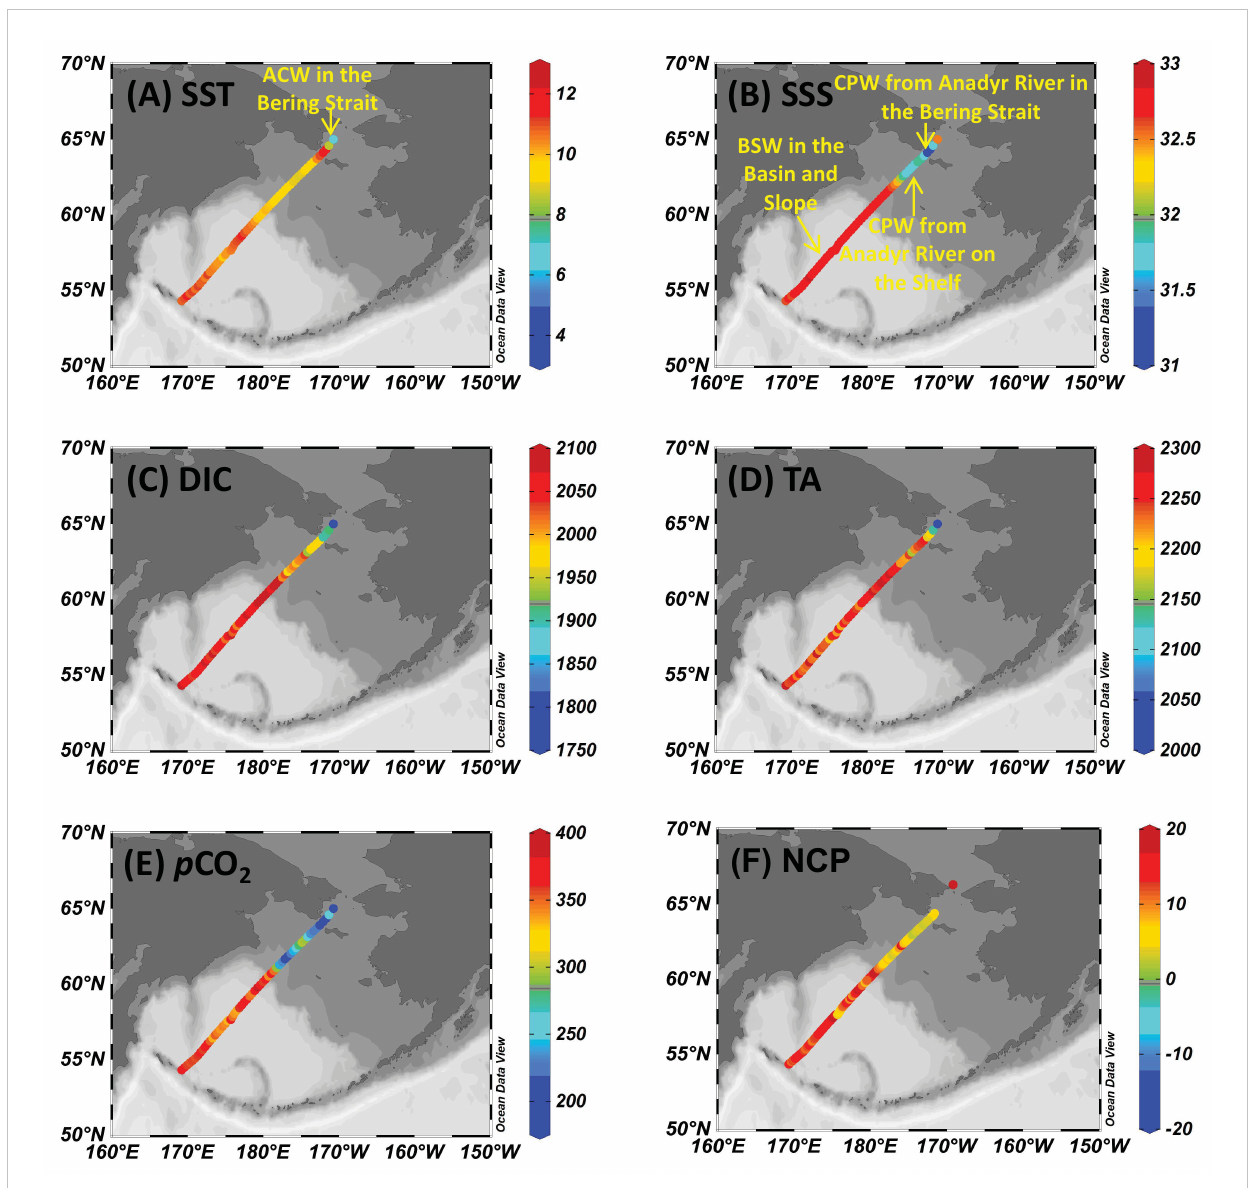
FIGURE 4 Sea surface distribution of (A) temperature, SST (°C), (B) salinity, SSS, (C) dissolved inorganic carbon, DIC (µmol kg -1 ), (D) total alkalinity, TA (µmol kg -1 ), (E) partial pressure of CO 2 , p CO 2 (µatm), and (F) net community production, NCP (mmol C m -2 d -1 ) during the forward voyage in